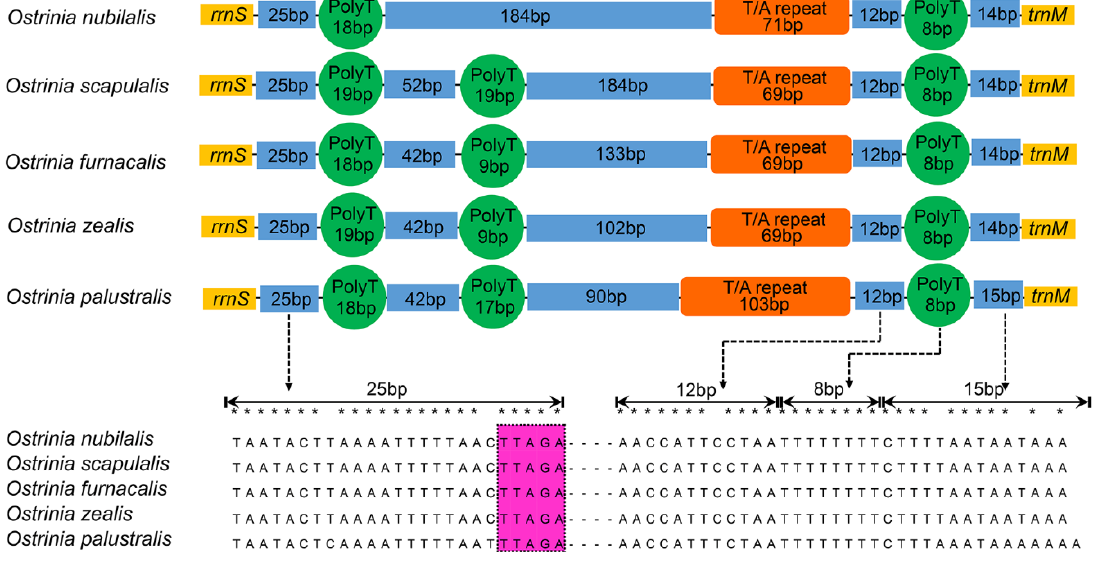
Figure 4. Organization of control region in mitogenomes of O. furnacalis , O. nubilalis , O. scapulalis , O. zealis , and O. palustralis . The orange block is the tandem repeat region, the dark blue block indicates non-repeat regions and the green circle is the poly-T stretch. The motif ‘TTAGA’ is highlighted by purple.